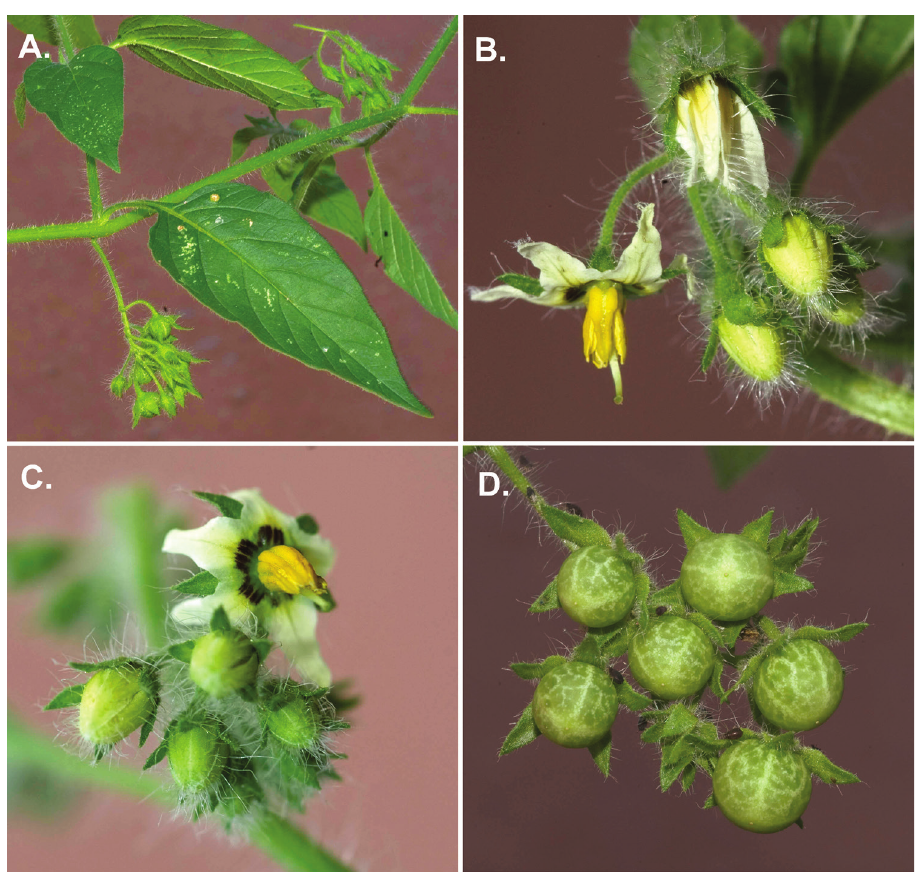
Figure 1. Solanum michaelis . A Fruiting stem B Inflorescence with details of indumentum of simple, multi-cellular eglandular and glandular trichomes along the stem, calyx and corolla C Flower at full an- thesis with buds D Maturing fruit ( A–D Nee & Flores 54821 : photos by Michael Nee).